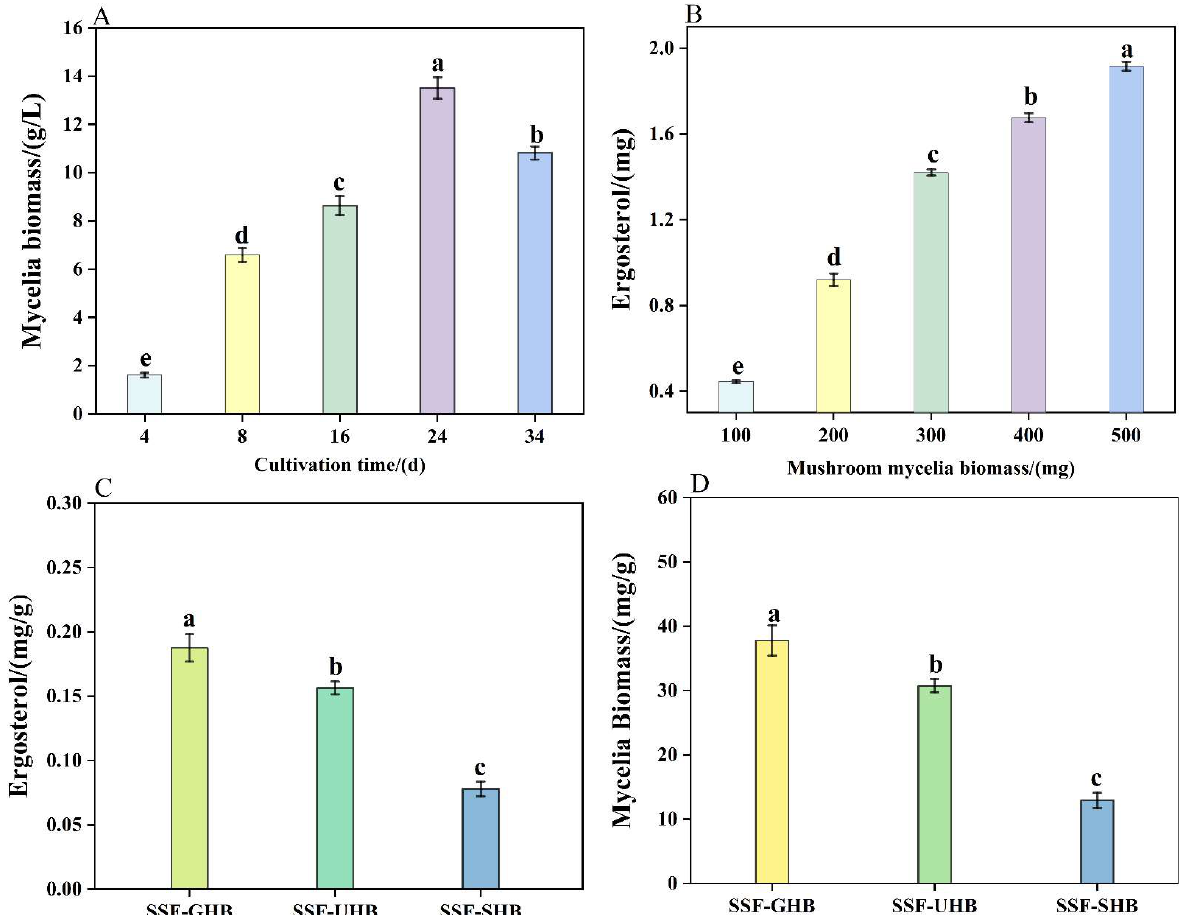
Figure 2. Ergosterol constituents of the highland barley colonized with A. sinodeliciosus var. Chaidam ZJU-TP-08 mycelia. ( A ): Mycelia biomass (g/L) produced by submerse cultivation during 34 d; ( B ): Ergosterol curve of mycelial at 24 d of cultivation; ( C ): Ergosterol determined (mg/g) of colonized Highland barley, the different colors of legends represent different group, ( ) SSF-GHB, ( ) SSF-UHB, ( ) SSF-SHB; ( D ): Indirect determination of mycelial biomass (mg/g) of colonized Highland barley, the different colors of legends represent different group, ( ) SSF-GHB, ( ) SSF-UHB, ( ) SSF-SHB. a–e: Values were determined in triplicate. Equal letters indicated that there were no significant difference at 5% ( p > 0.05) in the parameter evaluated.